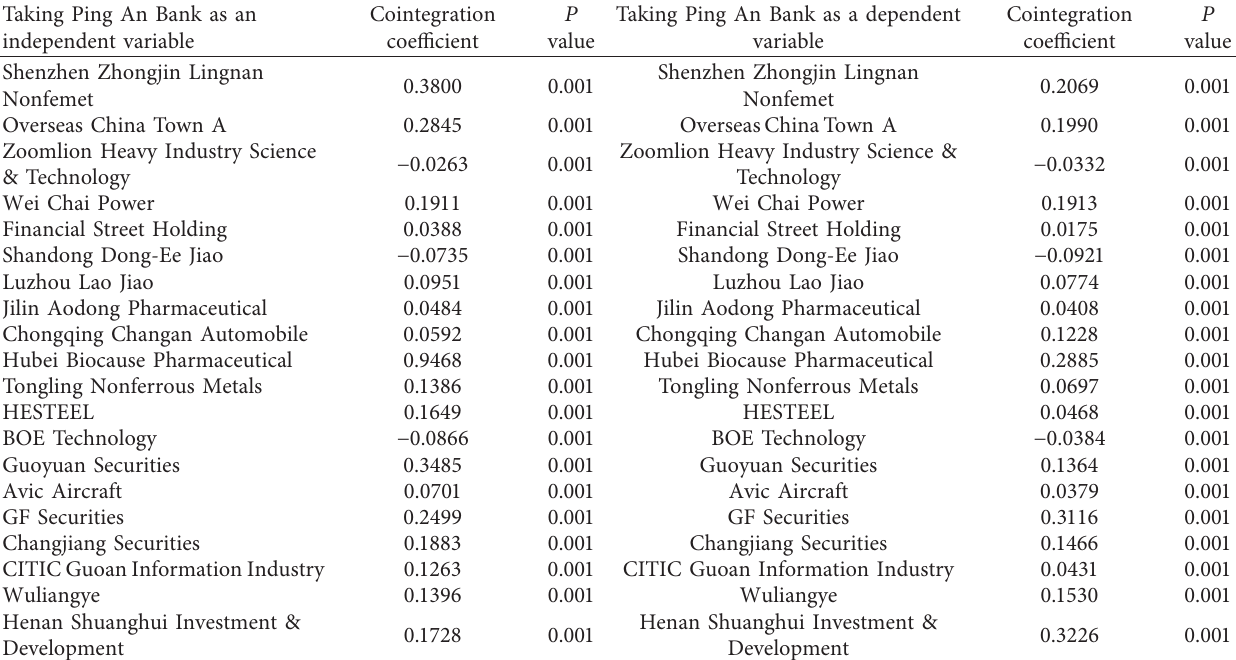
Table 2: Cointegration coefficient of Ping An Bank with other selected stocks during